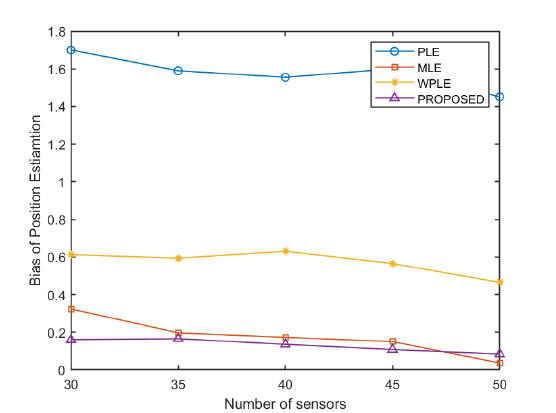
Figure 8. RMSE of position estimation versus bearing standard deviation.